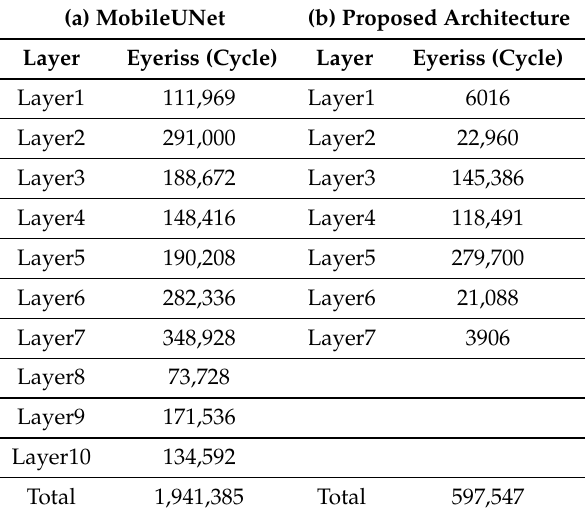
Table 10. Expected cycles on Eyeriss chips. (a) MobileUNet and (b) proposed